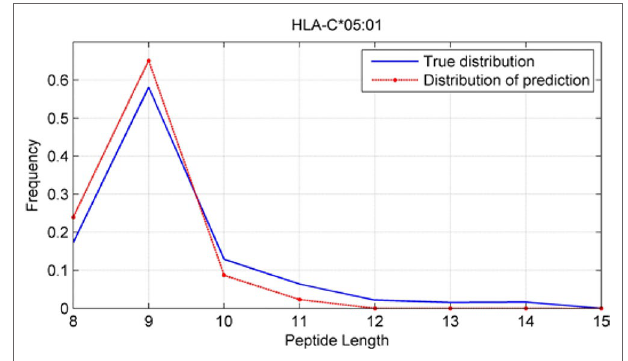
FIgURe 12 | Predicted length preference of